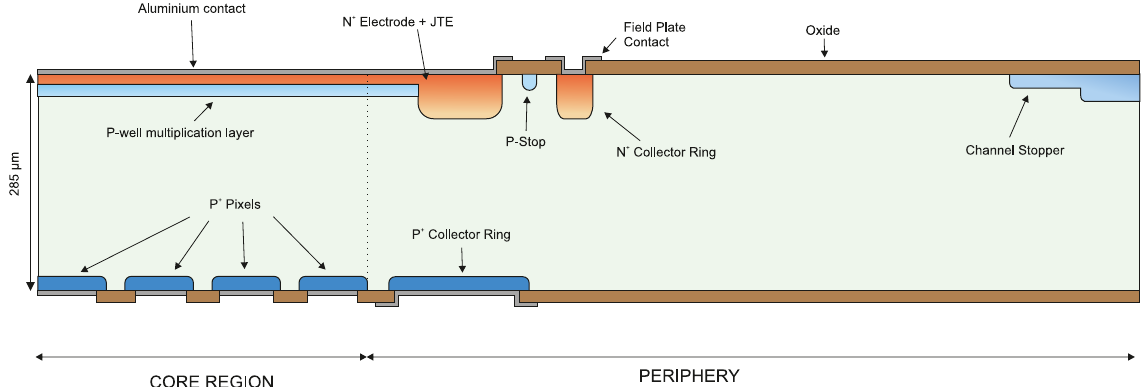
Figure 3. First iLGAD generation (iLG1) fabricated at IMB-CNM, not optimized for X-ray irradiation, with JTE and channel stopper. On the Omhic side, a collector ring is diffused in the